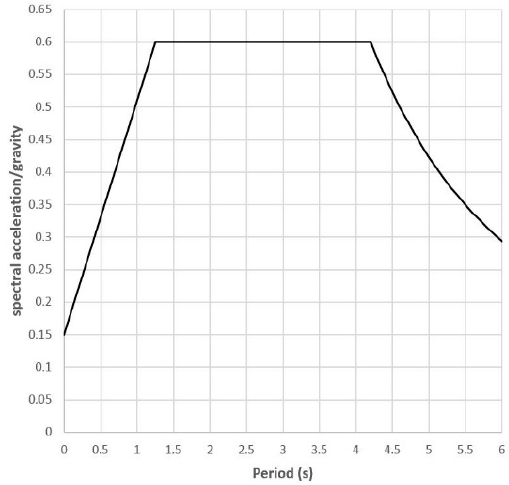
Figure 10. Design spectra for structures type A, according to [15].